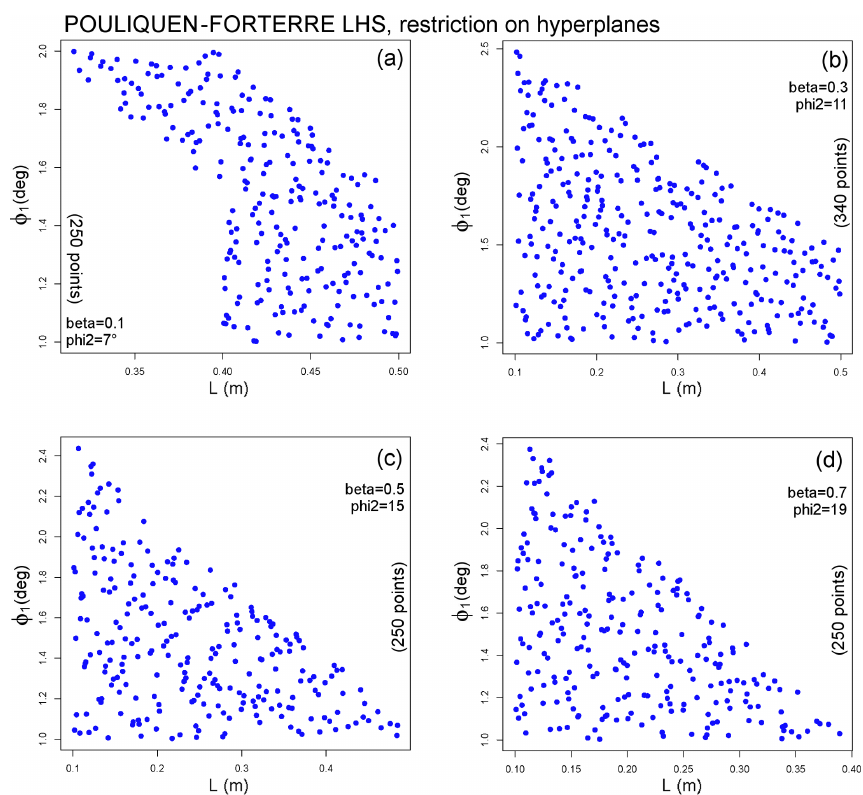
Figure 5. Overview of modified specialized experimental designs in PF, supported over the four different hyperplanes described in Fig. 3. All plots are projected along the V coordinate.